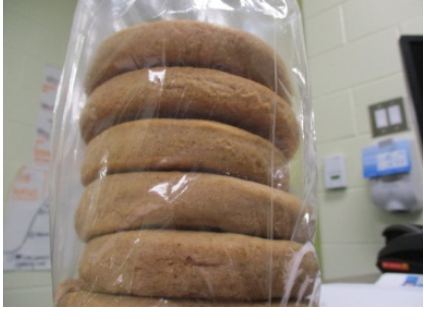
Figure 3. Grace, 15.